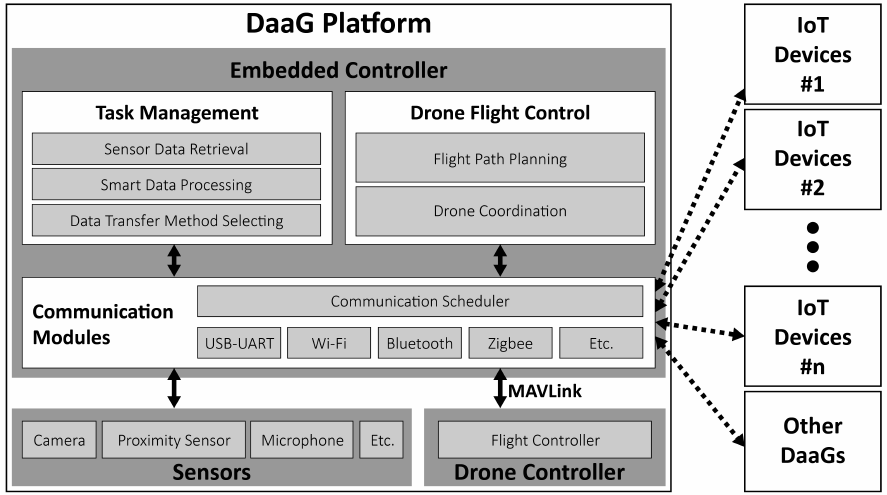
Figure 2. Structure of